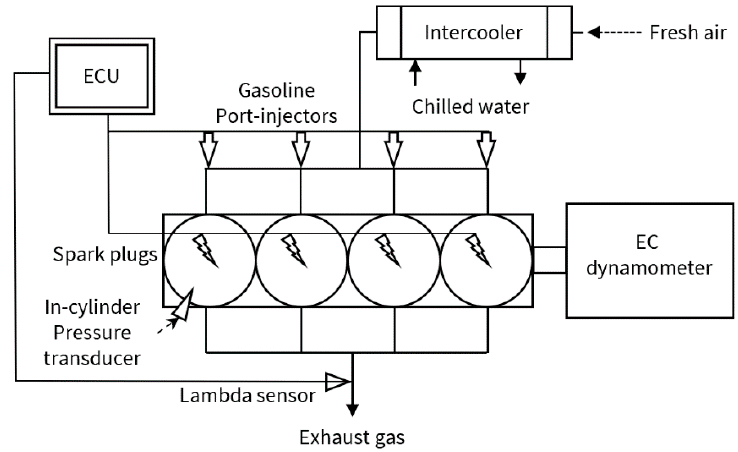
Figure 1. Schematic of the engine experimental facility.